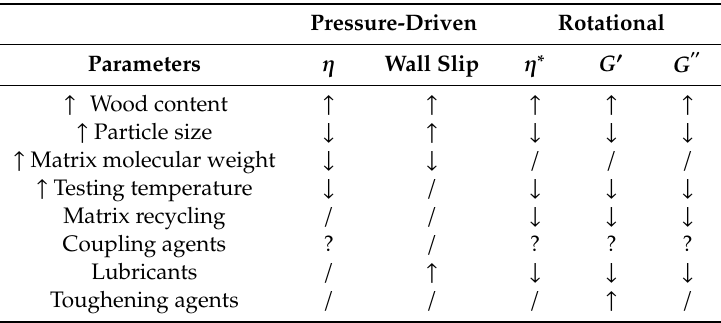
Table 7. General results obtained varying the main parameters (viscosity η , complex viscosity η ∗ , (cid:48)(cid:48) storage modulus, G (cid:48) , loss modulus, G ) that a ff ect the rheological properties. ↑ stands for “increase”, ↓ stands for “decrease”, / stands for “not present in the literature”, and ? stands for “still debated in the literature”. Pressure-Driven Rotational Parameters η Wall Slip η ∗ G (cid:48) G (cid:48)(cid:48) ↑ Wood content ↑ ↑ ↑ ↑ ↑ ↑ Particle size ↓ ↑ ↓ ↓ ↓ ↑ Matrix molecular weight ↓ ↓ / / / ↑ Testing temperature ↓ / ↓ ↓ ↓ Matrix recycling / / ↓ ↓ ↓ Coupling agents ? / ? ? ? Lubricants / ↑ ↓ ↓ ↓ Toughening agents / / / ↑